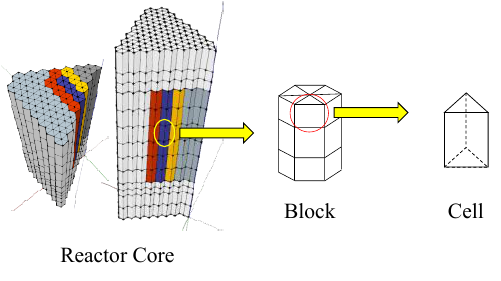
Figure 1. Hierarchy of Mesh Structure in